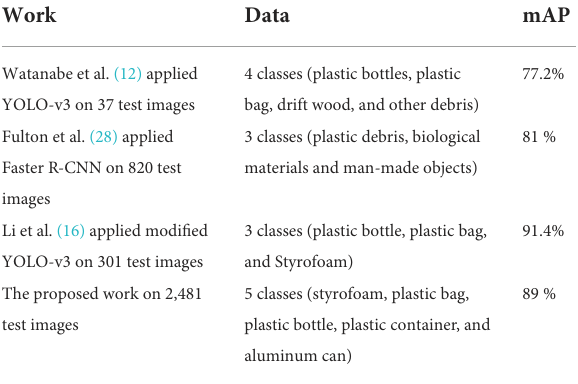
TABLE 5 Benchmarking the proposed work with previous works on garbage